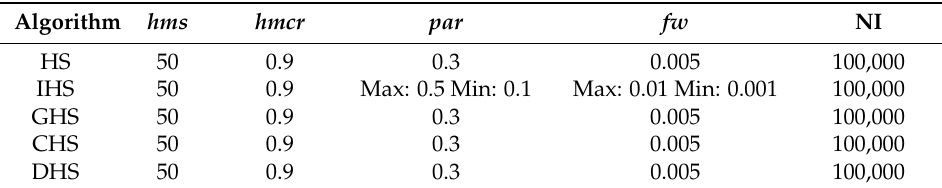
Table 2. Parameters of the